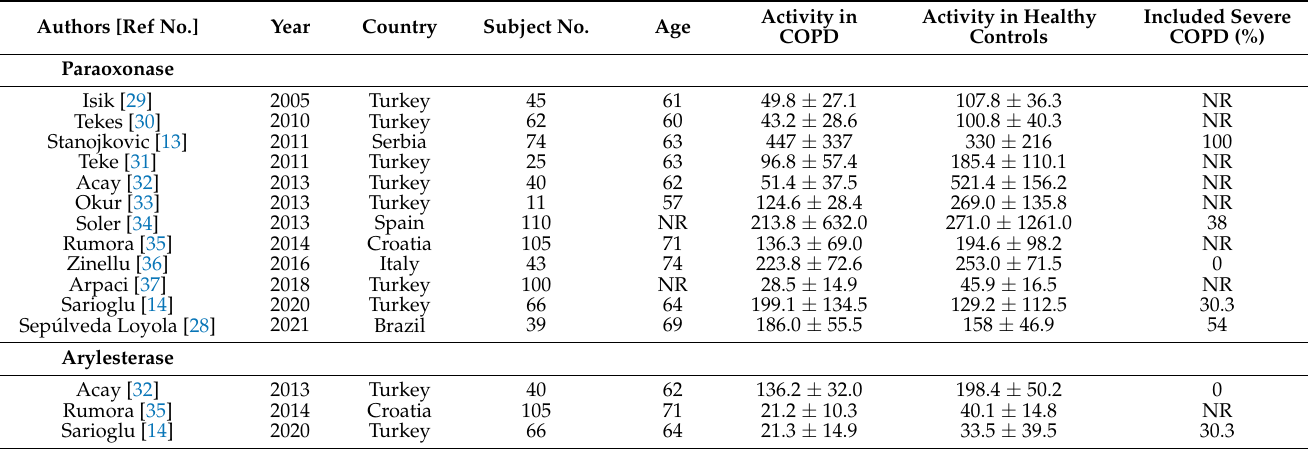
Table 1. Summary of the included articles on PON1 activity in patients with